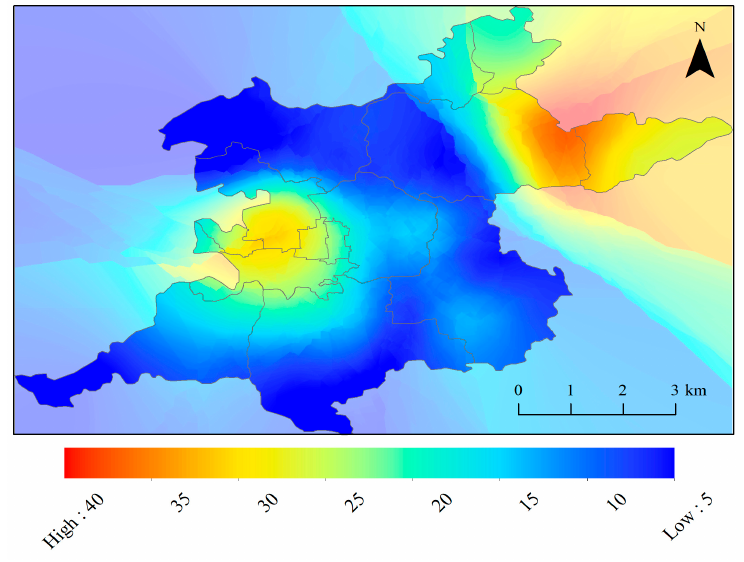
Figure 15. The errors (mm/year) of GWSA trends from the residual between simulated results and △ GWL. The region outside the Beijing Plain is set with a transparency of 30% in the color map.